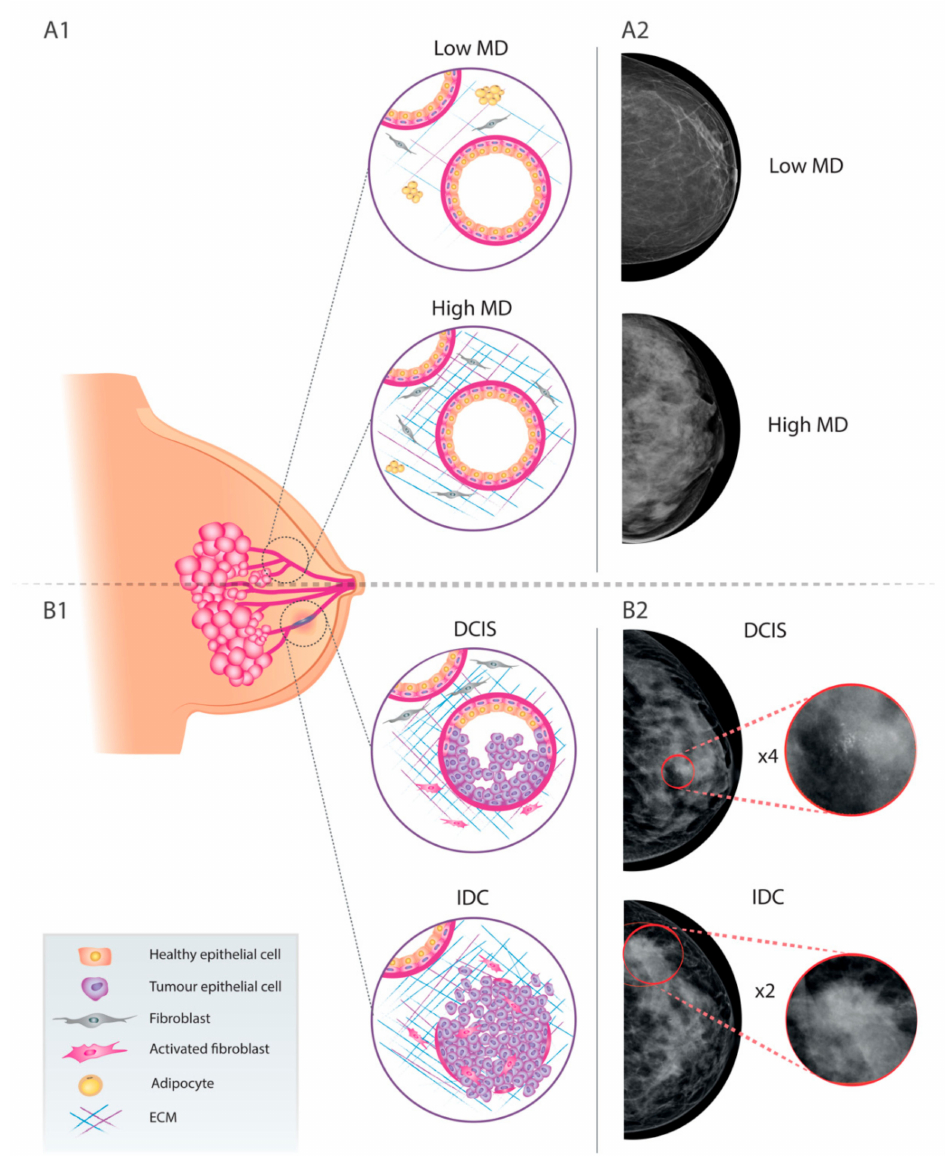
Figure 1. Schematic representation of mammary gland organisation and representative mammograms of healthy breast tissue, including low ( A 1) and high ( A 2) mammographic density areas; and malignant lesions, including DCIS ( B 1) and IDC ( B 2). MD: mammographic density; DCIS: ductal carcinoma in situ; IDC: invasive ductal